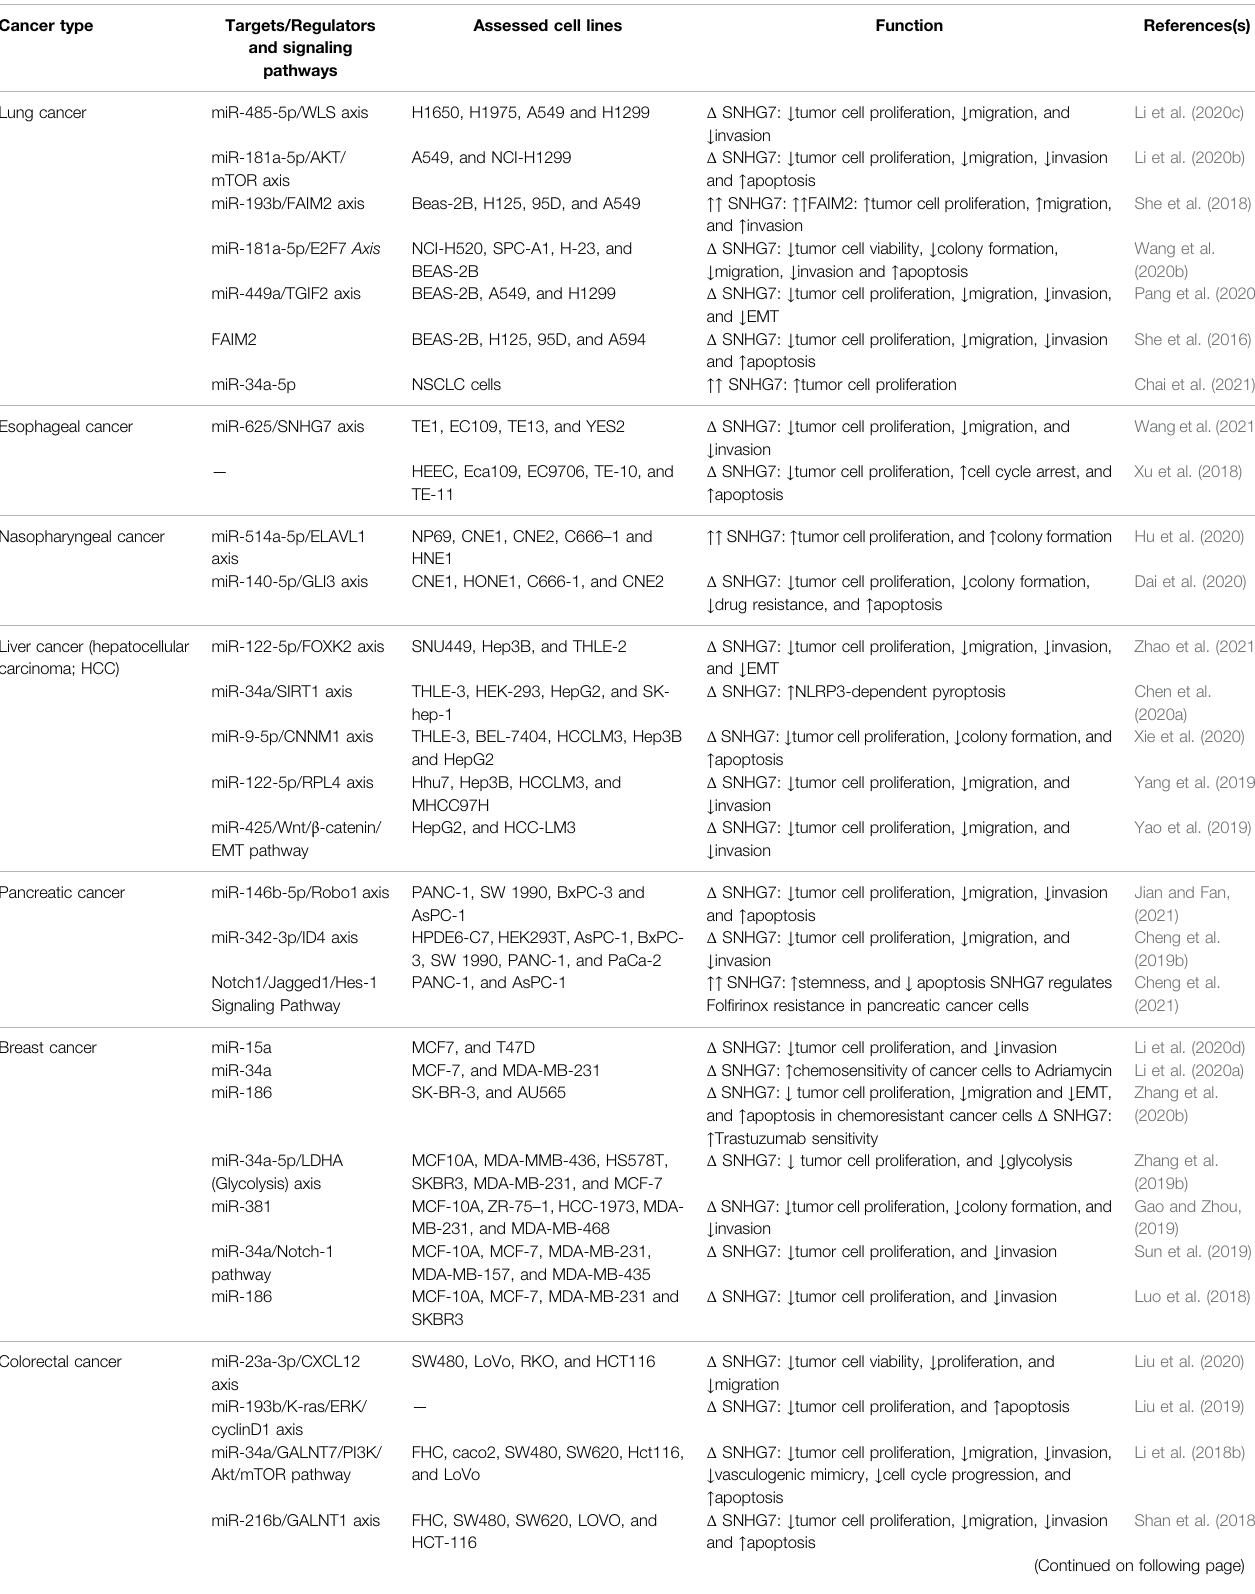
TABLE 3 | An overview to the oncogenic in fl uences of SNHG7 in cell studies of different types of cancer. Cancer